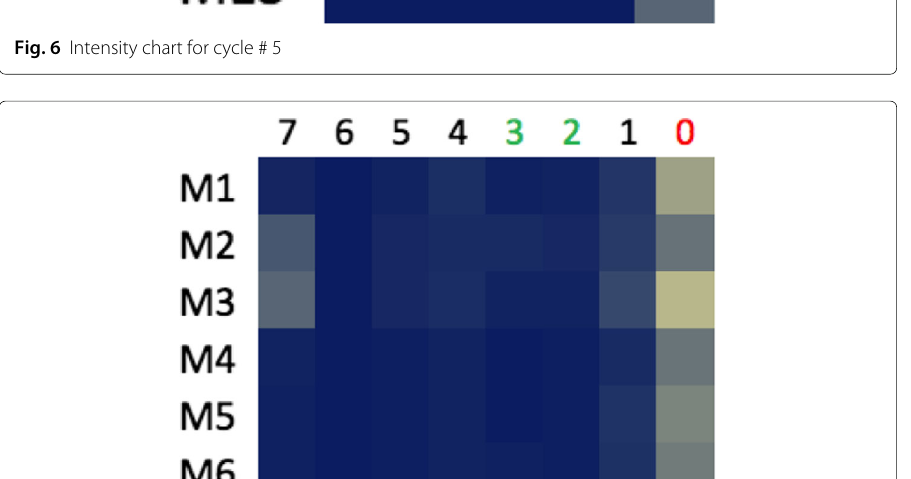
Fig. 6 Intensity chart for cycle # 5